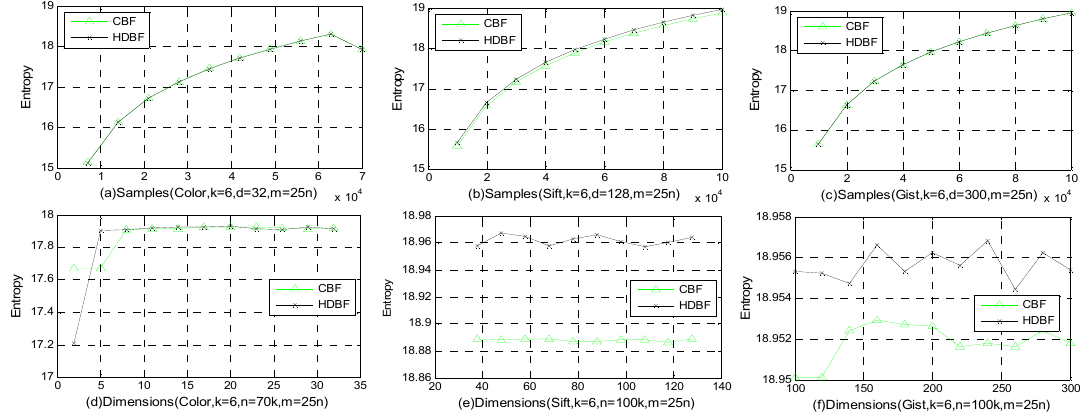
Figure 4. Entropies of CBF and HDBF for different samples.